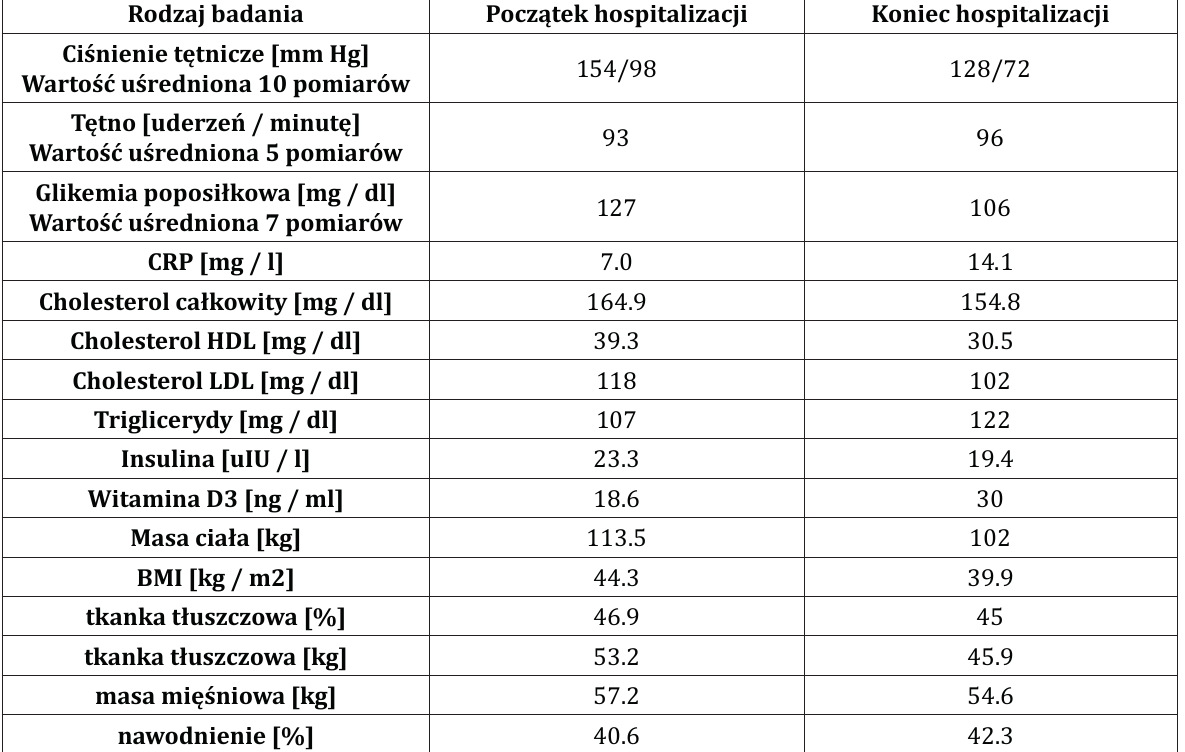
Tabela 2. Zestawienie pomiarów ciśnienia tętniczego, tętna i wyników badań